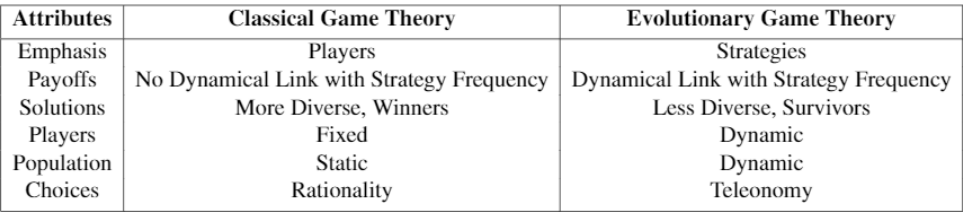
Figure 1. Differences Between Classical Game Theory and Evolutionary Game